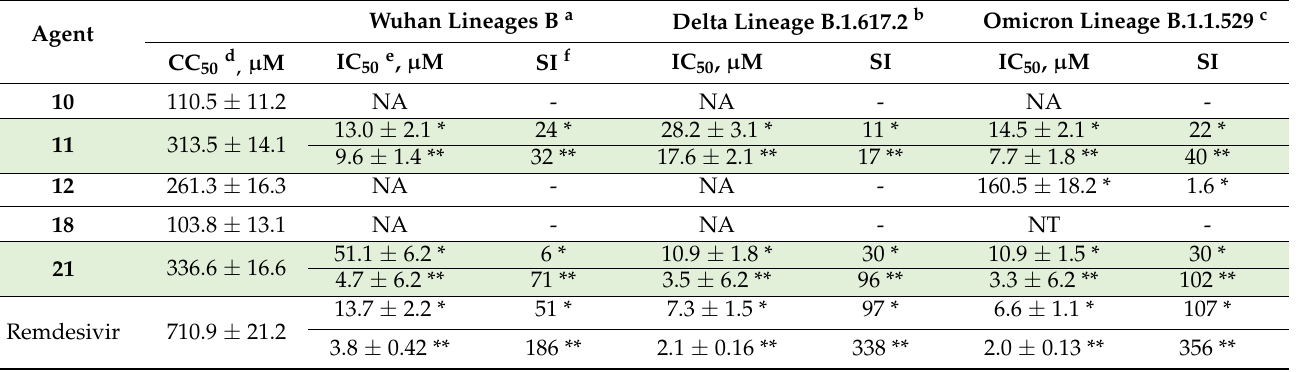
Table 2. Antiviral activities of derivatives 10 , 11 , 12 , 18 and 21 against SARS-CoV-2 virus strains obtained on Vero E6 cell